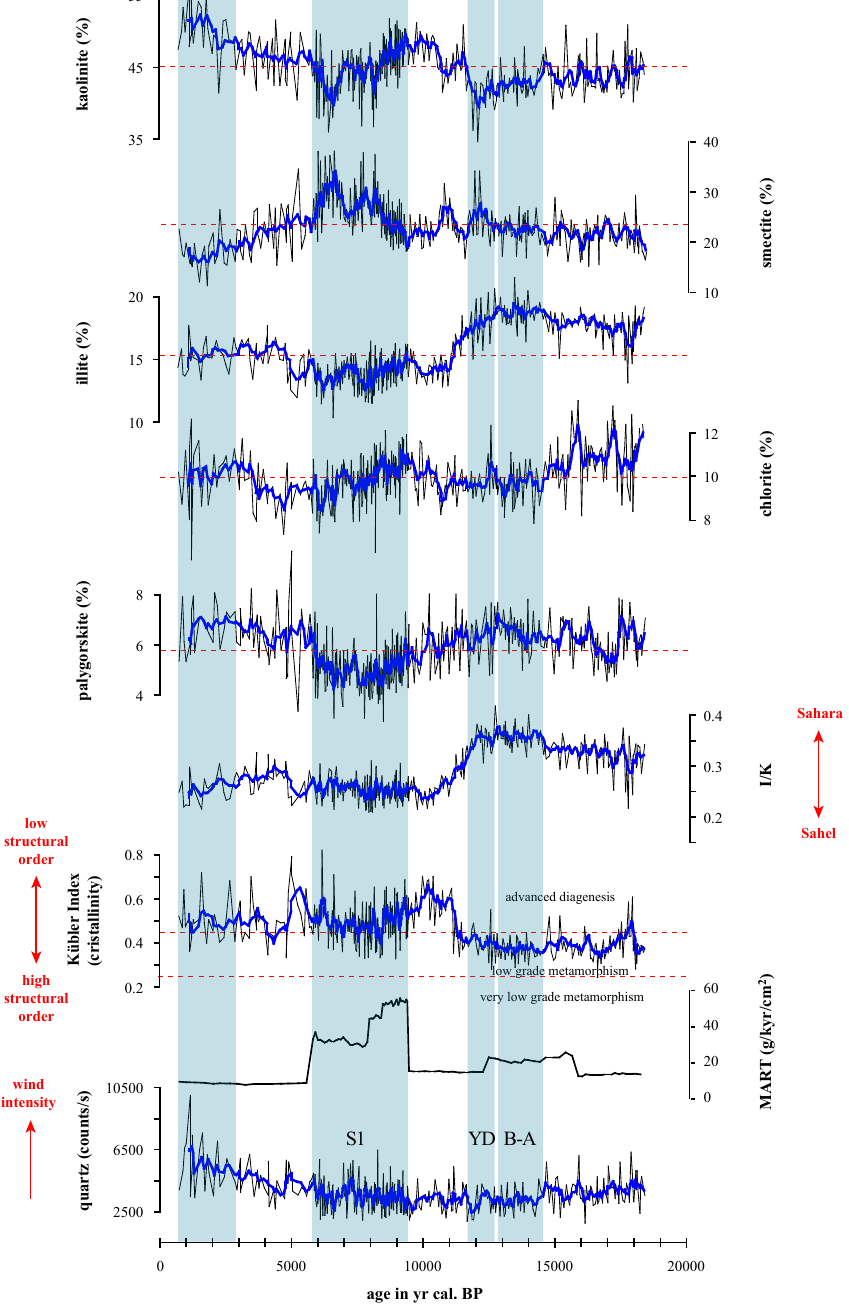
Fig. 2. Clay mineralogy of core MD04-2797: kaolinite (%), smectite (%), illite (%), chlorite (%), palygorskite (%), I / K: illite to kaolinite ratio, K¨ubler index (crystallinity), (MART) Terrigenous Mass Accumulation Rates (gkyr − 1 cm − 2 ) and quartz content (counts/s) for the last 20000yr. B–A=Bølling–Allerød, YD=Younger Dryas, S1=sapropel S1 (Mercone et al., 2000).